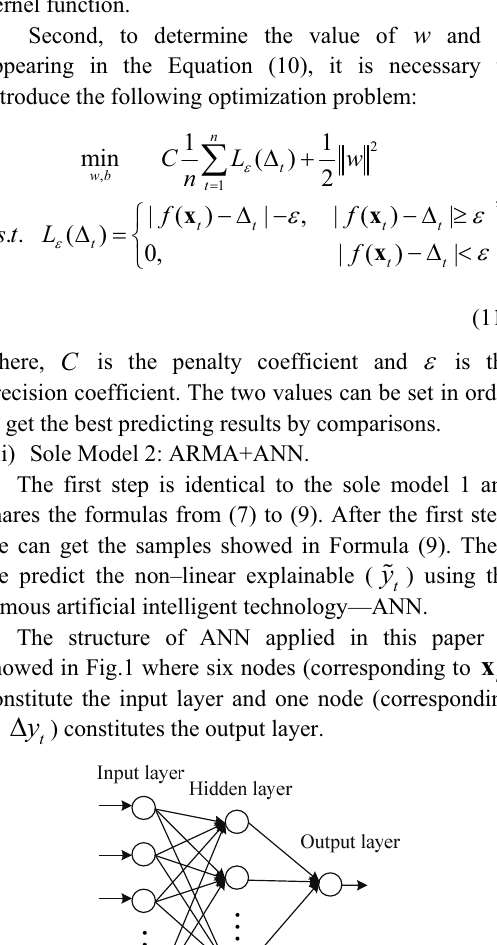
Fig.1 Structure Chart of Artificial Neural Network